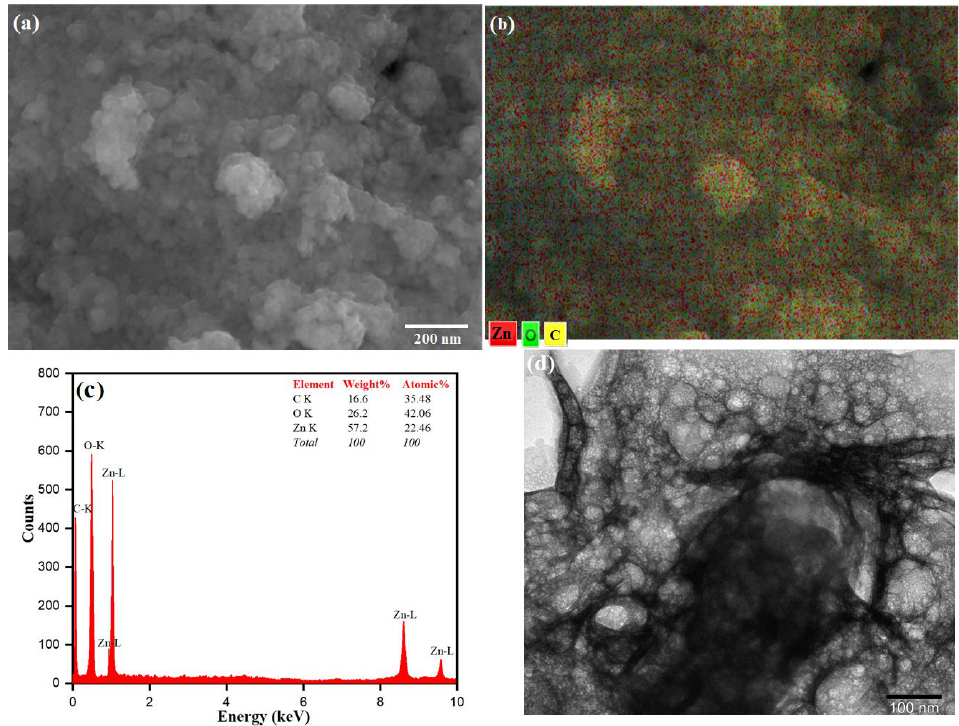
Figure 5. ( a ) SEM image, ( b ) Elemental mapping, ( c ) EDX spectrum and ( d ) TEM image of ZnO NPs.